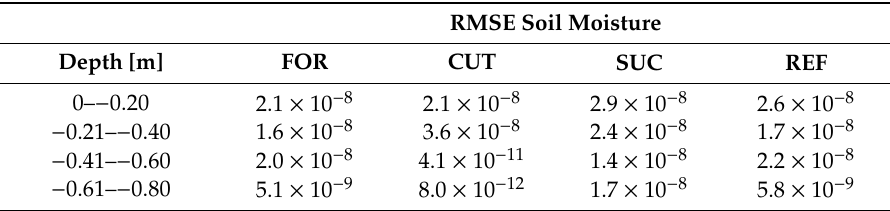
Table 9. Root mean square error (RMSE) interpolated raster soil moisture.